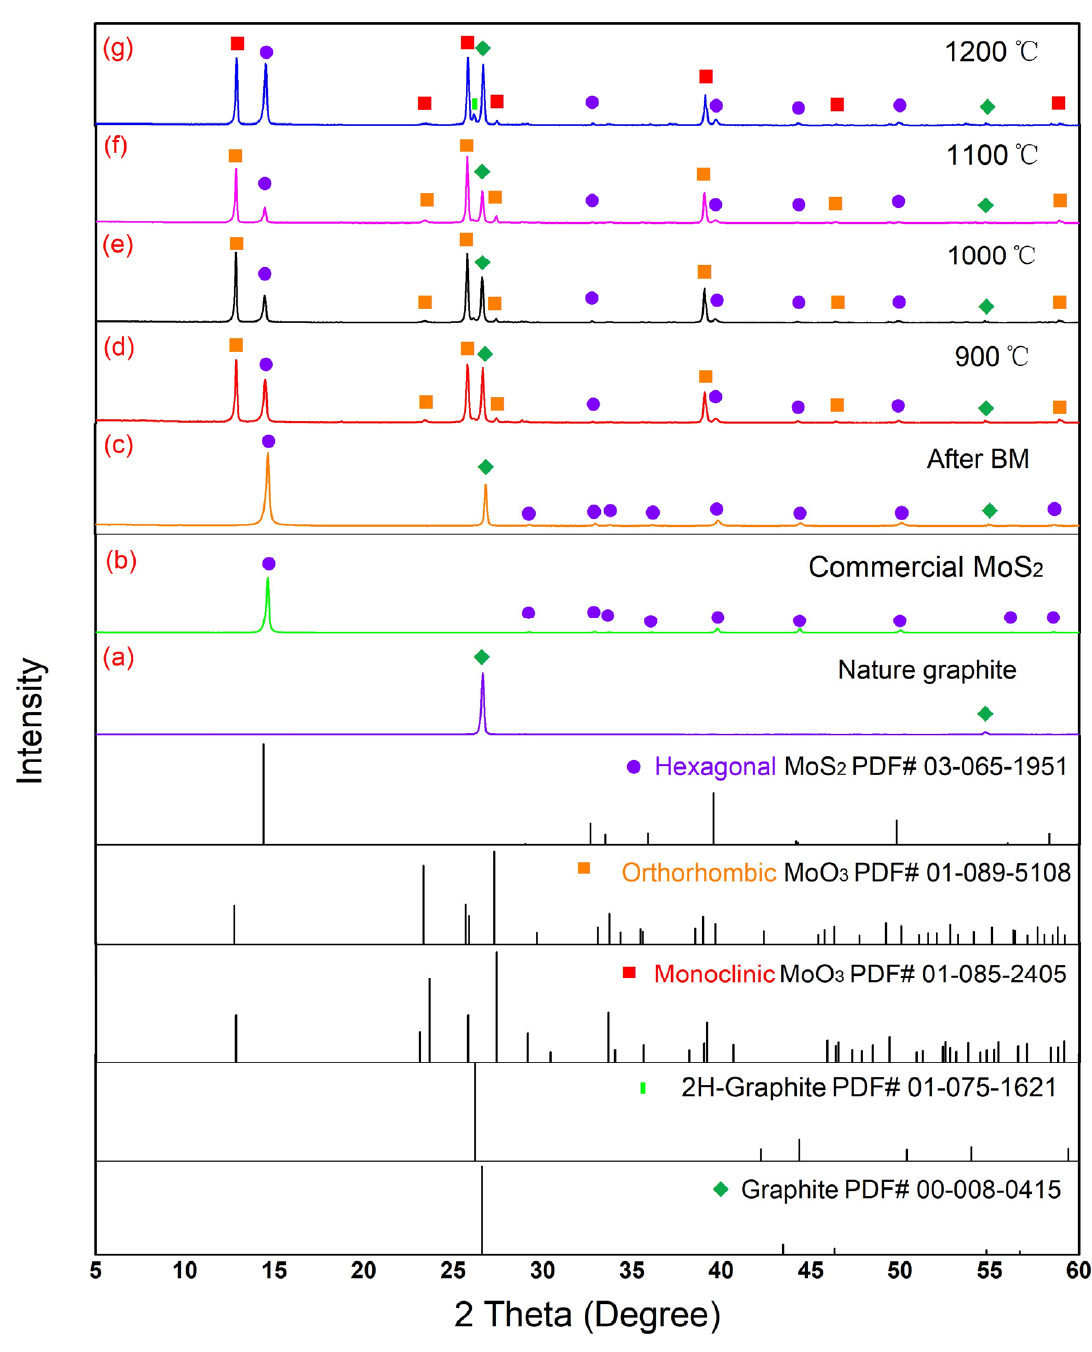
Figure 3. XRD patterns of various precursor materials and products: ( a ) the non-purified natural graphite material, ( b ) the commercial MoS 2 , ( c ) the mixture after ball milling; and ( d – g ) nanostruc- tured materials obtained at various temperatures.